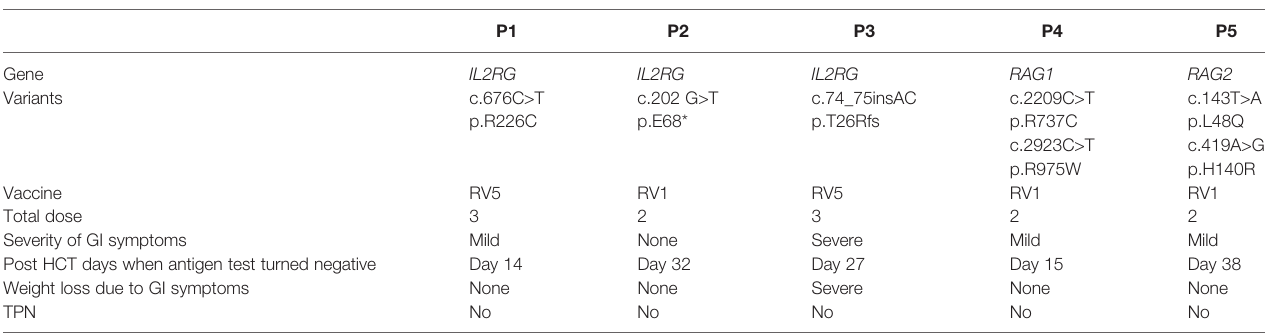
TABLE 1 | Clinical features of 5